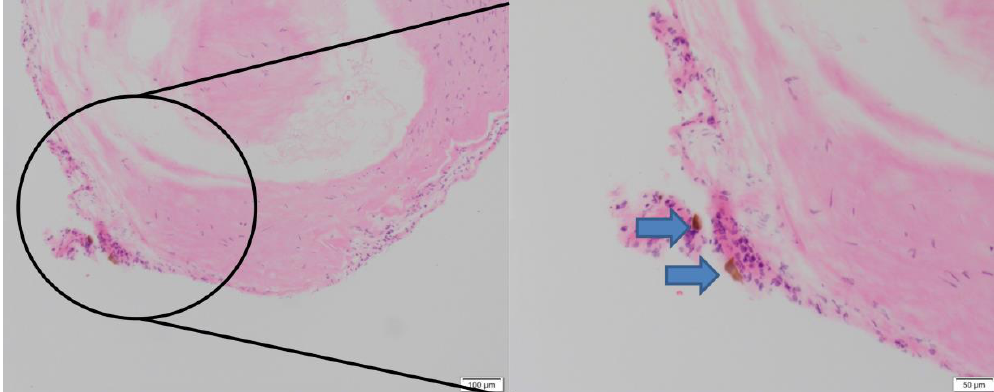
Figure 3. Immunohistochemical analysis of aneurysm dome tissue for hemosiderin. A subject with left terminal ICA aneurysm with presentation of SH and positive QSM shows presence of hemosiderin (blue arrows) on immunohistochemical hematoxylin and eosin staining of aneurysm wall tissue harvested during microsurgical clipping of aneurysm.